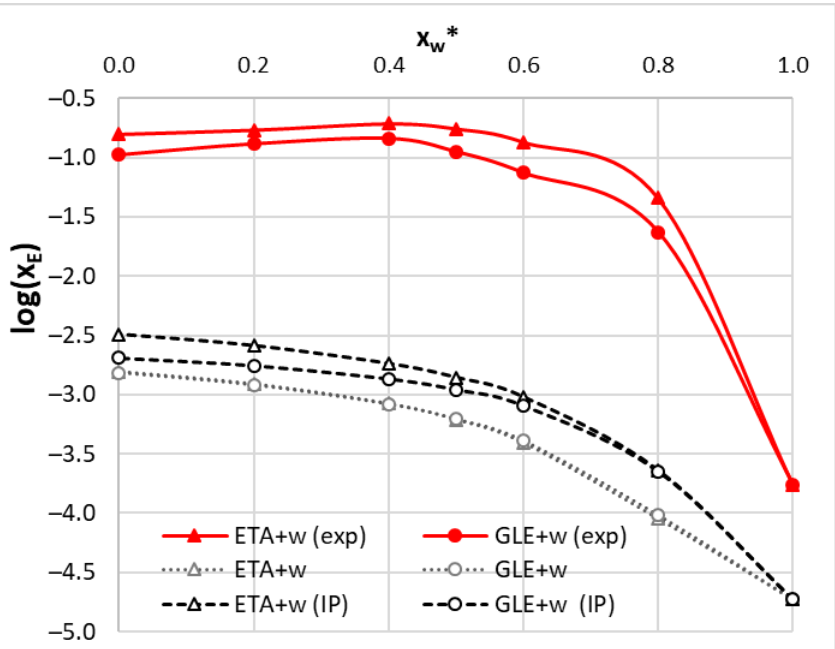
Figure 6. The room temperature trends of edaravone solubility in ethaline (ETA = ChCl:Et = 1:2) and glyceline (GLE = ChCl:Gl = 1:2) as a function of water molar fraction (x W* ) in solute-free solutions. Solid red lines represent experimentally measured solubility, black dashed lines stand for solubility computed using the ion pair model and gray dotted lines characterize values computed according to the molecular model of DES.